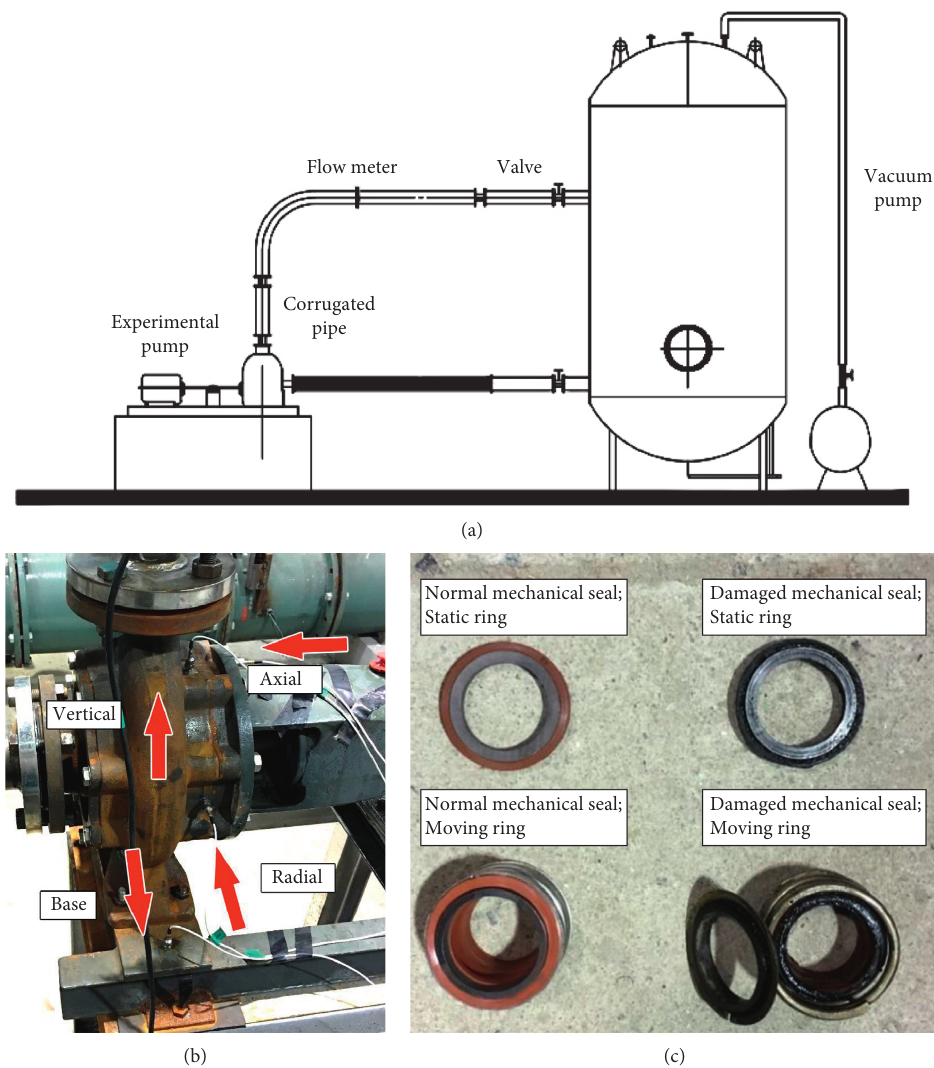
Figure 1: Test device. (a) Test circuit. (b) Test-bed. (c) Mechanical